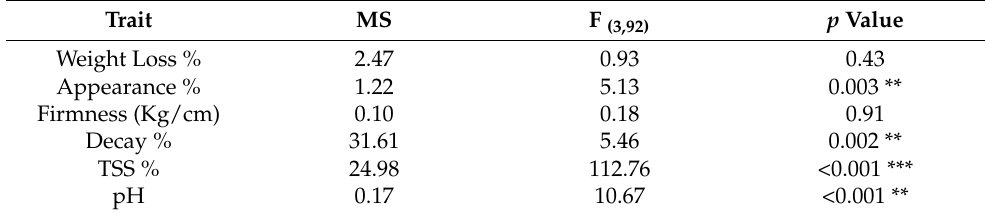
Table 1. Analysis of variance of bio-stimulants for the morphological and physiological traits of okra pods stored for 12 days.